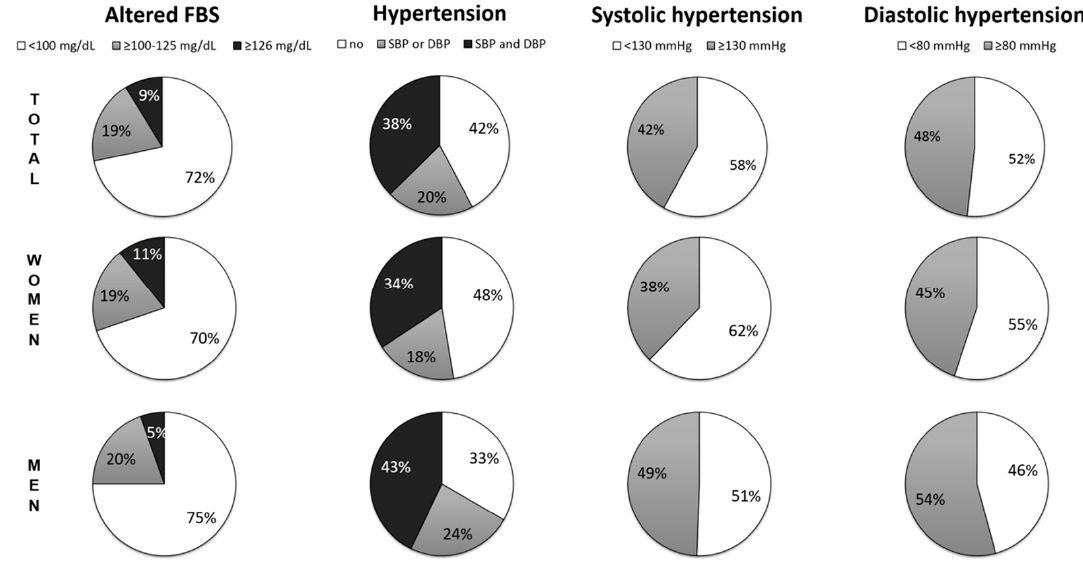
Figure 2. The prevalence of altered fasting blood sugar (FBS), hypertension, systolic hypertension or diastolic hypertension in the total population (first line), in women (second line), and in men (third line). According to the American Diabetes Association (2016) [21], impaired glucose tolerance was defined as FBS ≥ 100–125 mg/dL (gray) and diabetes mellitus (DM)-suspected was defined as ≥ 126 mg/dL